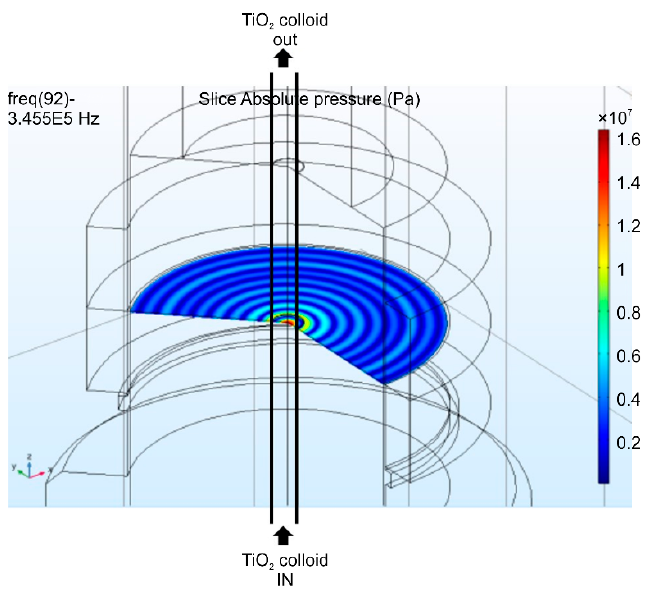
Figure 4. Three-dimensional sound field modeling of the focused ultrasound radiation.